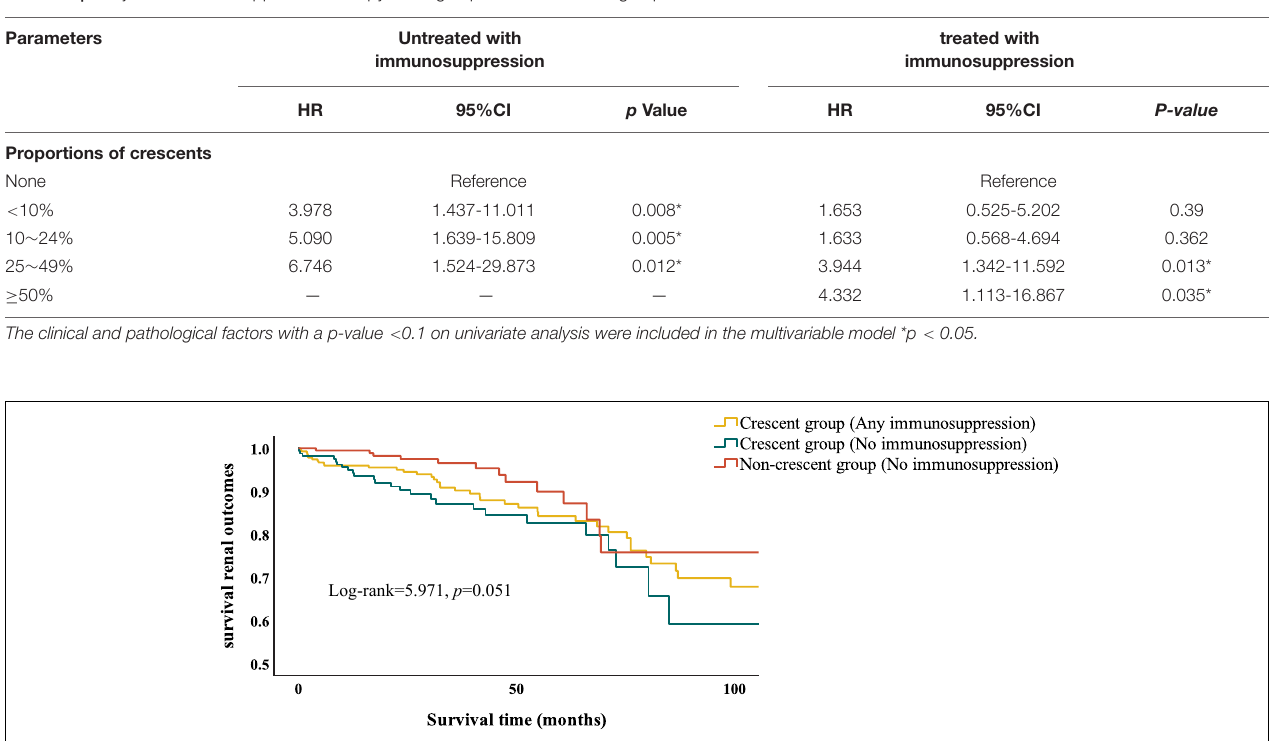
TABLE 5 | Analysis of immunosuppressive therapy in subgroups of the crescents group.